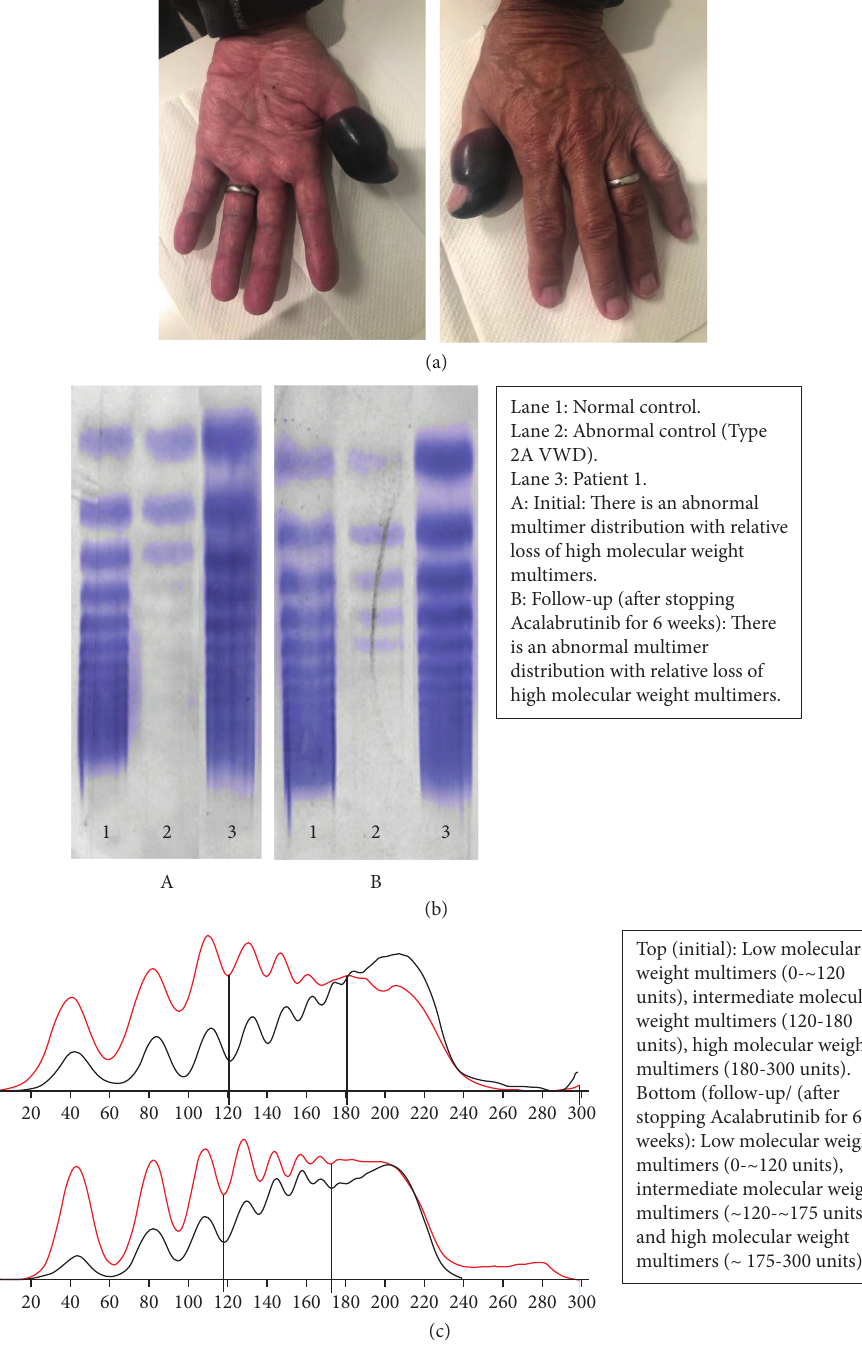
Figure 4: (a) Thumb hematoma. (b) Multimeric analysis of von Willebrand factor was performed by an agarose gel electrophoresis followed by immunofixation with antivon Willebrand factor antiserum. (c) Densitometry scan of an agarose gel following immunofixation. There is an abnormal multimer distribution with a relative loss of high molecular weight multimers (patient: blue line; normal control: black